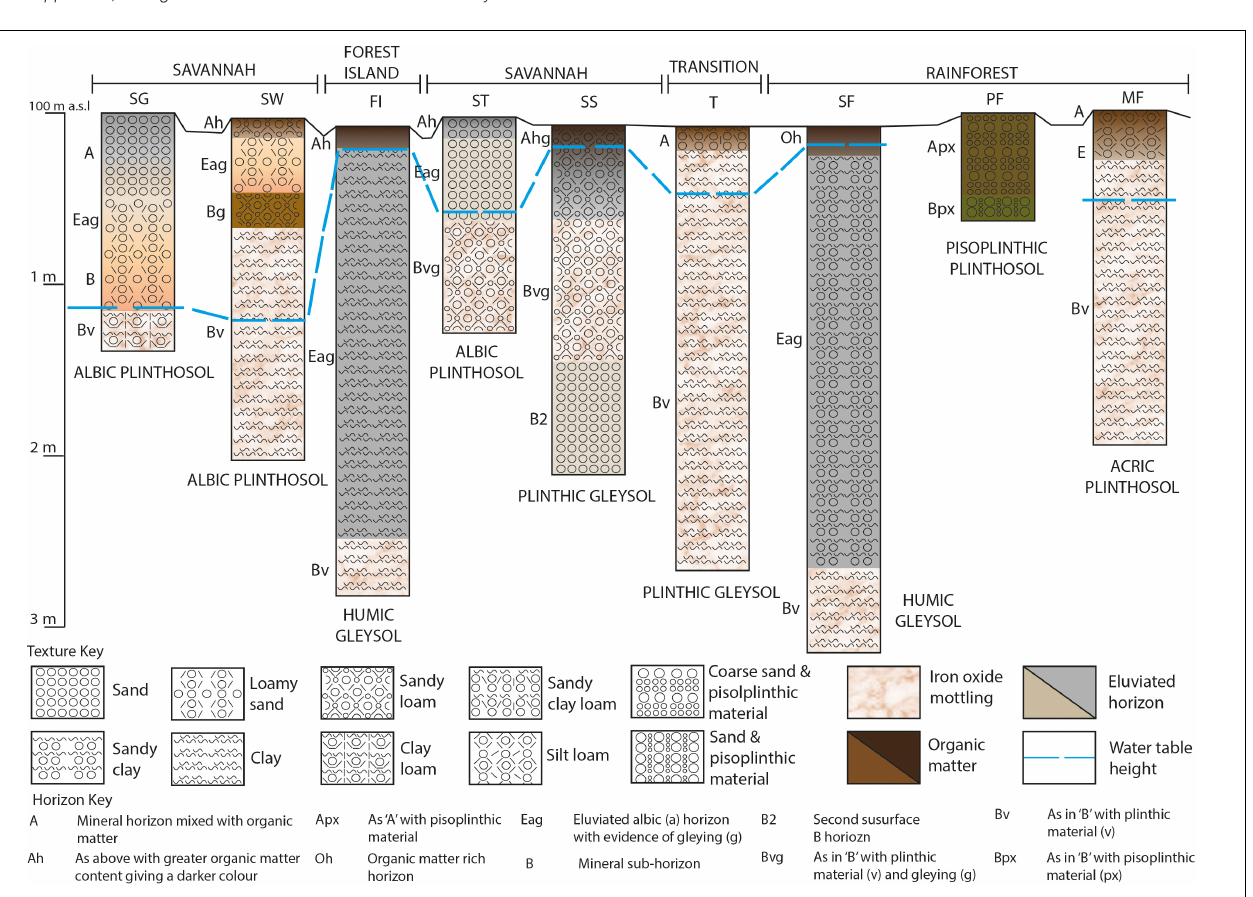
Frontiers in Forests and Global Change |